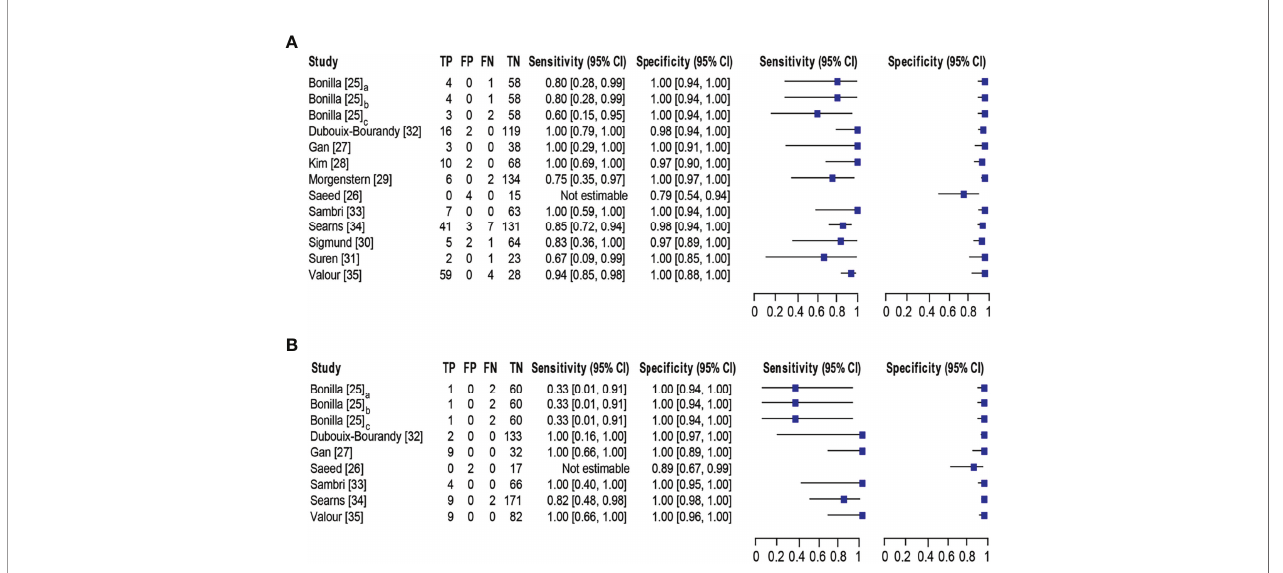
FIGURE 3 | Forest plot for detection of (A) MSSA and (B) MRSA. Bonilla [25] comprises three datasets that have been designated as Bonilla [25] a , Bonilla [25] b , and Bonilla [25] c to distinguish them. Bonilla [25] a , Bonilla [25] b , and Bonilla [25] c compares the sensitivity/speci fi city of conventional PCR, LightCycler PCR, and TaqMan PCR to microbiological culture, respectively. The black line shows the study ’ s con fi dence interval, while the square re fl ects its sensitivity and speci fi